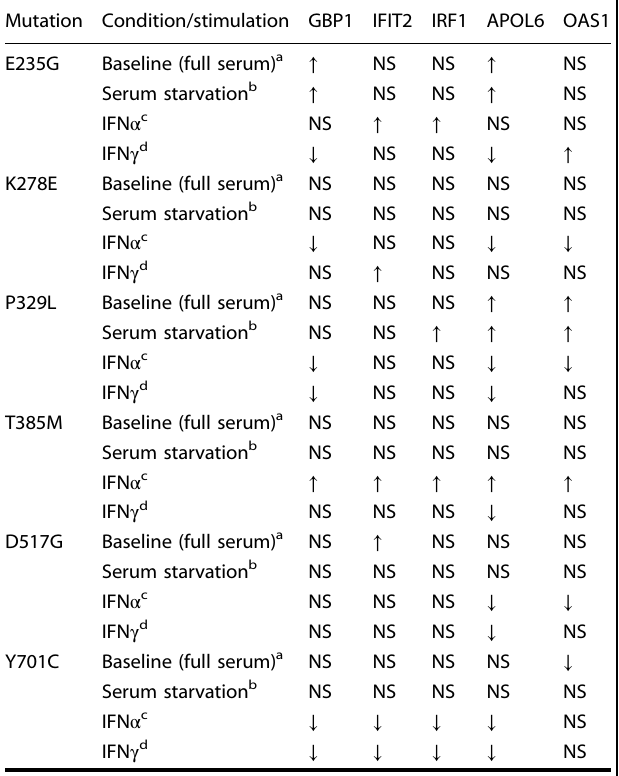
Table 3. Summary of differences in relative expression or fold increase across STAT1 mutants compared with wild type under various